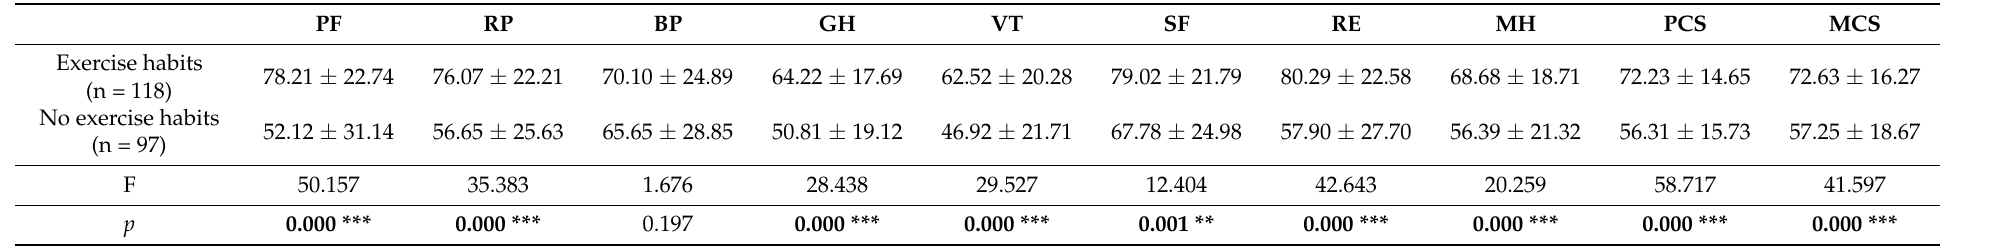
Table 1. Degree of HRQOL according to the presence of exercise habits.